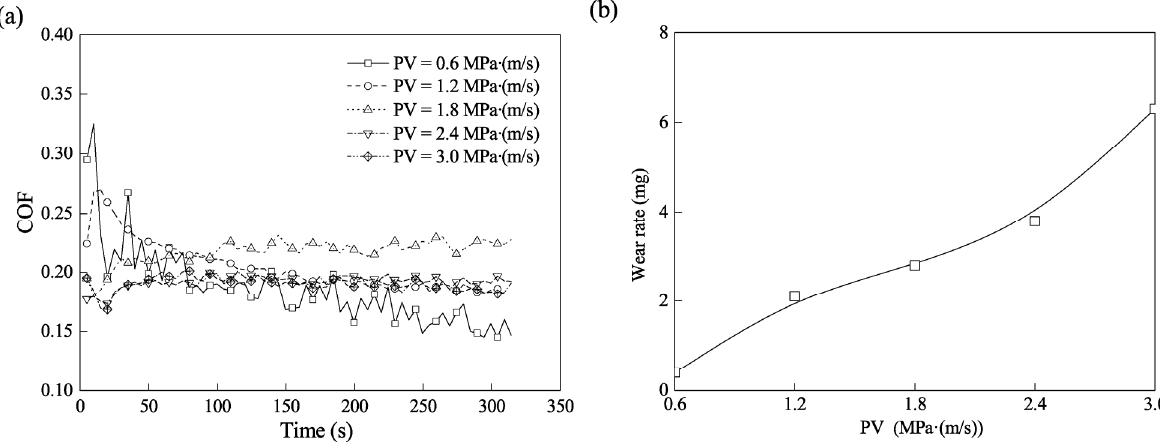
Fig. 4 (a) COFs and (b) wear rate with the S07steel disk under the dry-friction